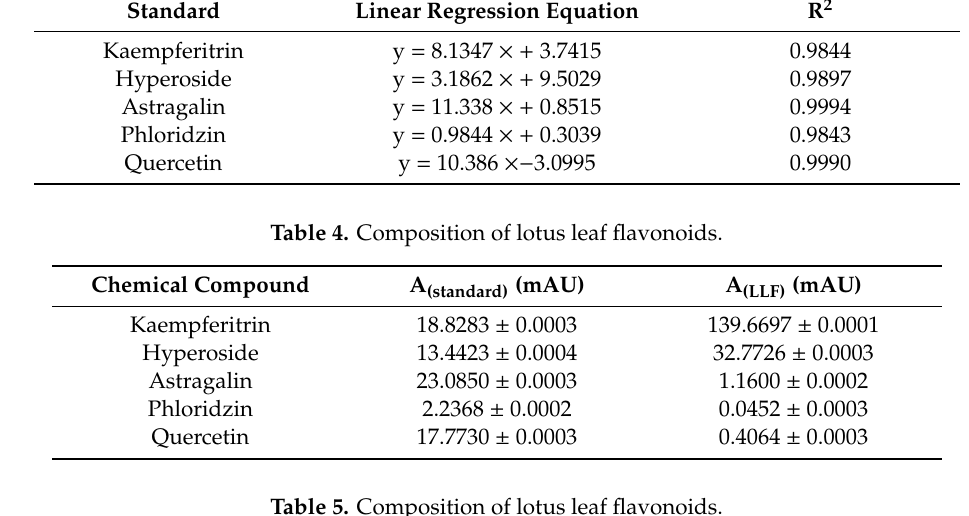
Table 5. Composition of lotus leaf